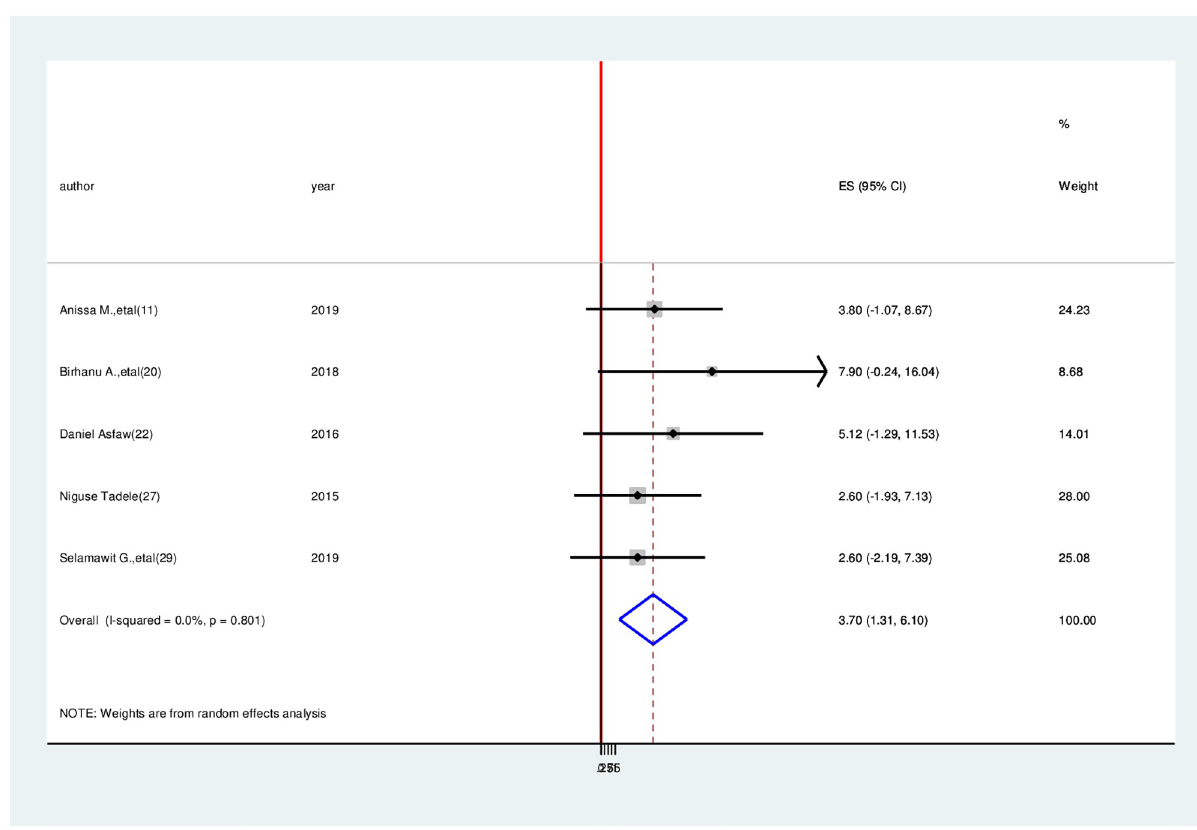
Fig 6. Association between average monthly income and health-related quality of life among cancer patients in Ethiopia, 2021.